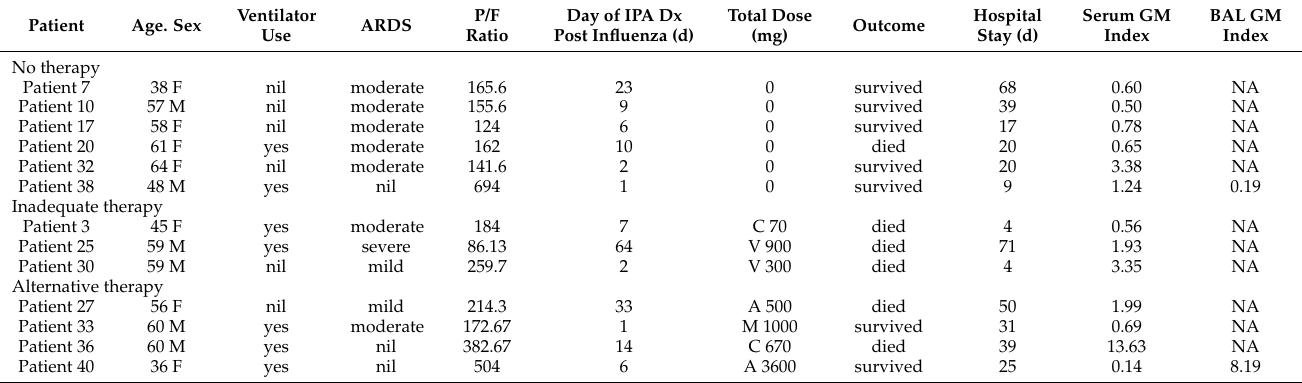
Table 2. The clinical characteristics of IPA in severe influenza patients who were not given any antifungal therapy ( n = 6) or were not given it in time to treat, such that patients died within one day of therapy ( n = 3), that could be arbitrarily regarded as inadequate antifungal therapy. Four patients received an echinocandin for alternative therapy. Patient Age. Sex